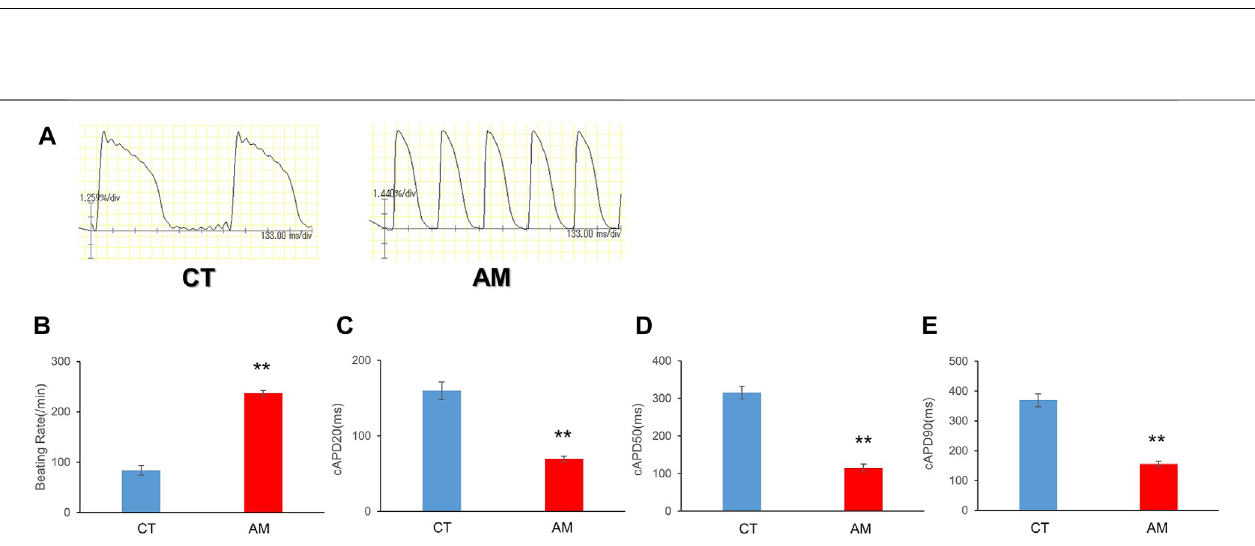
FIGURE 2 | Optical action potential (OAP) of CT (control hiPS-CMs) or AM (RA treatment hiPS-CMs). Representative waveforms for AP of CT or AM. The comparison ofAPparameters:beatingrate, cAPD20, cAPD50,and cAPD90,betweenCTand AM.Error bars representSD ofthemean from thevalues ofindependent experiments. ** p < 0.01, n (cid:2)